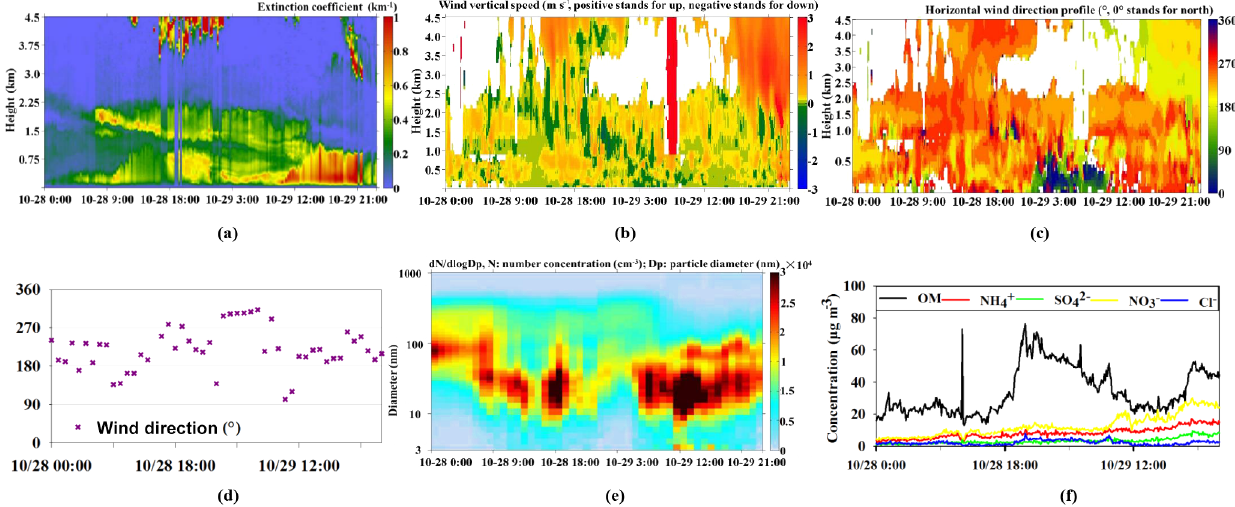
Figure 4. Characteristics of particulate matters and meteorological parameters during episode 1. (a) Vertical profile of extinction coefficient (Yongledian site), (b) vertical profile of wind vertical direction and speed, (c) horizontal wind direction profile, (d) wind direction on the ground, (e) particle size distribution, (f) NR-PM 1 chemical components.